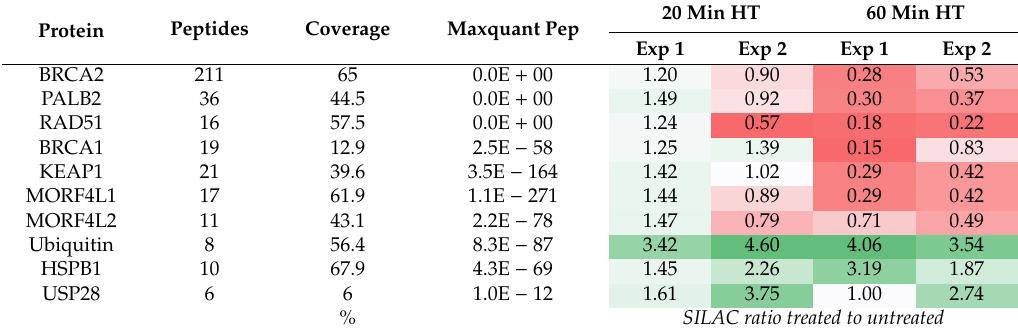
Table 1. GFP nanobody bead pull-down from Brca2 GFP / GFP mES cells labelled for three-state Stable Isotope Labelling with Amino acids in Cell culture (SILAC). Brca2 GFP / GFP mES cells were labelled with Light (L, K0R0), Medium (M, K4R6), and Heavy (H, K8R10) SILAC states. The cells were lysed in immunoprecipitation bu ff er immediately after the exposure to 42 ◦ C for 0, 20, or 60 min. Precipitated proteins were separated by Sodium Dodecyl Sulfate-Polyacrylamide Gel Electrophoresis (SDS-PAGE) and analyzed by mass spectrometry. The treated to untreated SILAC ratios from two independent reciprocal label-swap experiments are given in the table, comparing 37 ◦ C (“untreated”) with 20 min at 42 ◦ C (“treated”) in the first column, and 37 ◦ C with 60 min at 42 ◦ C (“treated”) in the second. 20 Min Protein Peptides Coverage Maxquant Pep